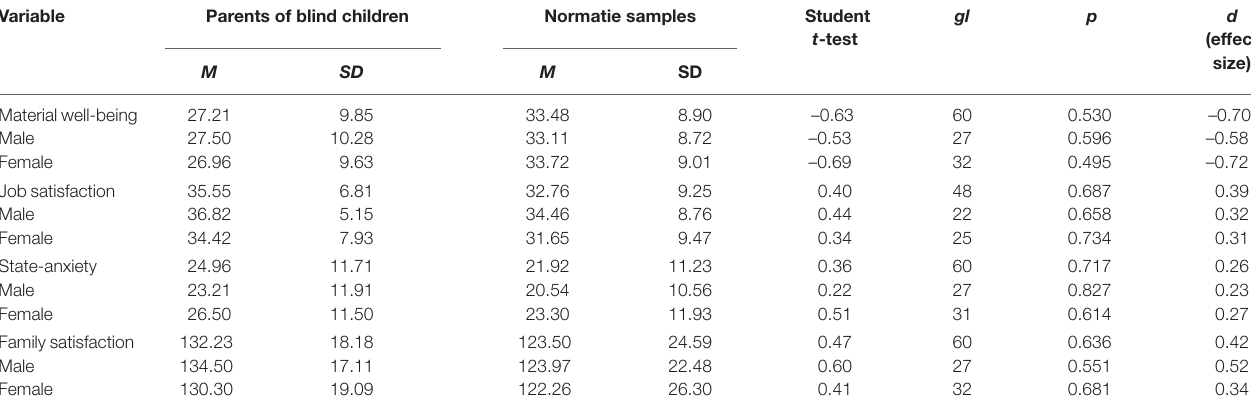
TABLE 1 | Descriptive statistics and comparison of the variables material well-being, job satisfaction, and family satisfaction with normative samples.